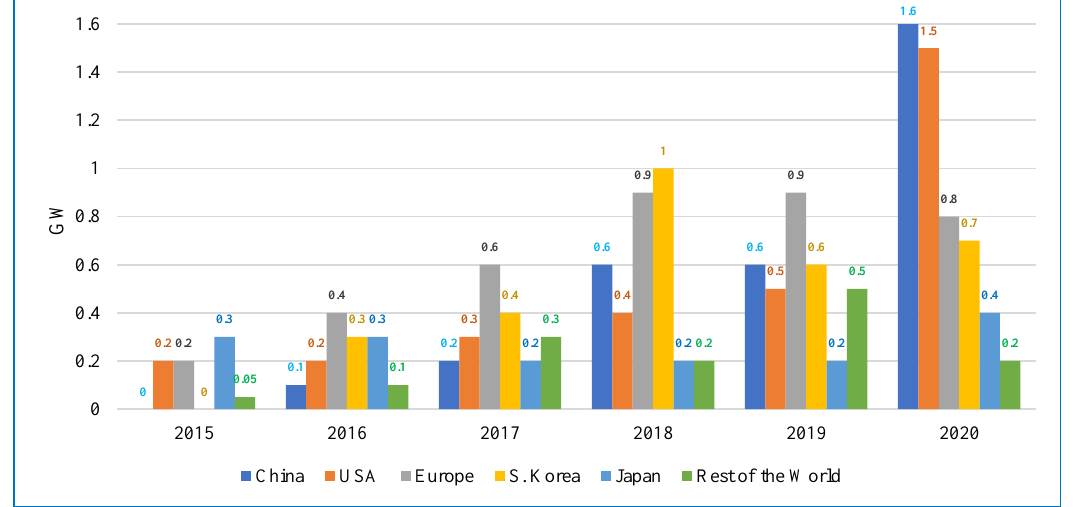
Figure 7. Energy storage additions per country from 2015 to 2020 [47].